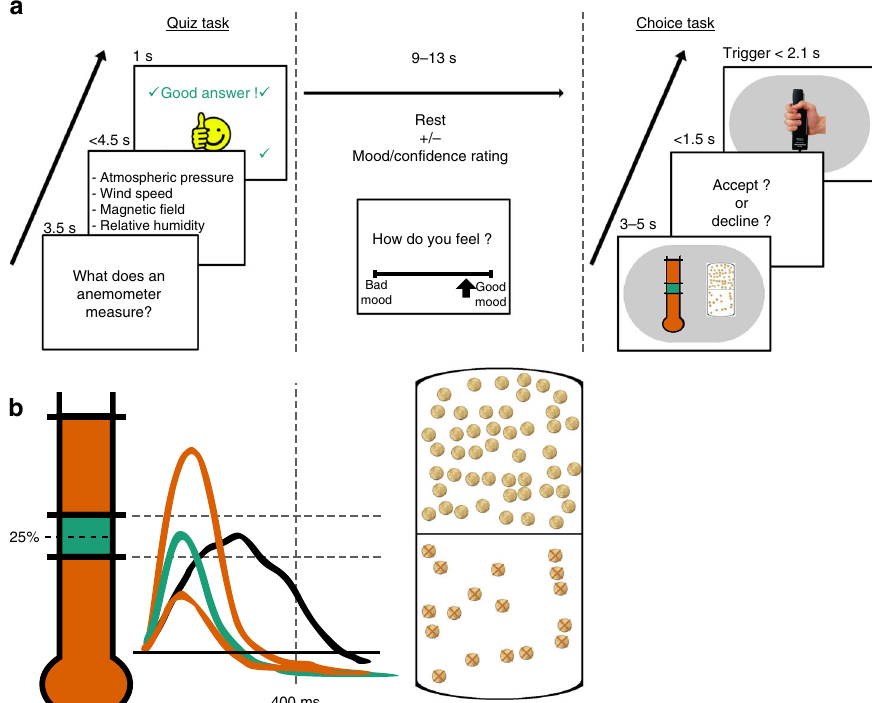
Fig. 1 Behavioral tasks. a Trial structure. Each trial included two unrelated tasks. In the quiz task (left), participants had to select one of four possible answers to a general knowledge question. In the choice task (right), participants had to decide between accepting or declining a motor challenge. The two tasks were separated by a rest period. In a subset of participants, subjective ratings of mood (or con fi dence) were inserted into the rest period. b Motor challenge. The challenge consisted in squeezing a handgrip such that the force peak would fall within a window around 25% of their maximal force. The green line represents a successful trial. Participants could fail because they squeezed too much (upper red line), not enough (lower red line) or for too long (more than 400 ms, black line). The challenge varied across trials along three dimensions that were indicated at the time of choice: dif fi culty, represented by the size of the target window (in green on a red thermometer), expected gain in case of success, represented by a bunch of regular 10-cent coins (in the upper part) and expected loss in case of failure, represented by a bunch of 10-cent crossed coins (in the bottom part). If subjects declined the challenge, they still had to squeeze the handgrip and try to hit the target window, but the stakes were minimized (expected gain and loss were fi xated at 50